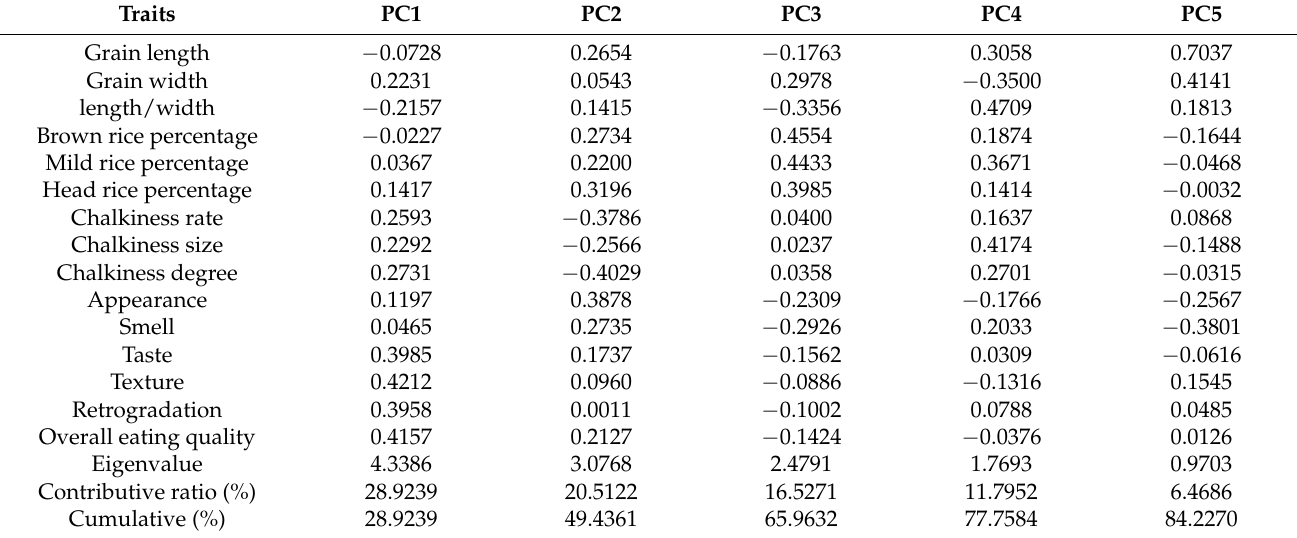
Table 3. Eigenvalue and contribution of each comprehensive index and loading matrix of each component for qualities of inbred japonica